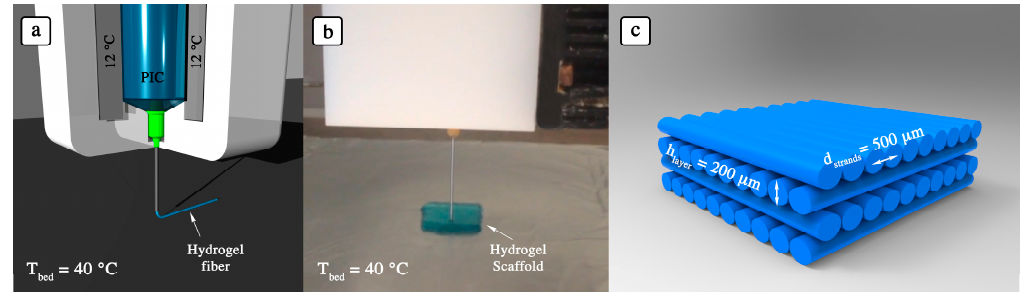
Figure 2. 3D printing of PIC hydrogel. ( a ) Schematic representation of low-temperature cartridge of 3D-Bioplotter. ( b ) 3D printing of PIC hydrogel: the low-temperature cartridge containing the PIC hydrogel was kept at 12 °C while the temperature of the printing bed was set at 40 °C. ( c ) Schematic representation of the printed PIC hydrogel with 0–90° fiber orientation.